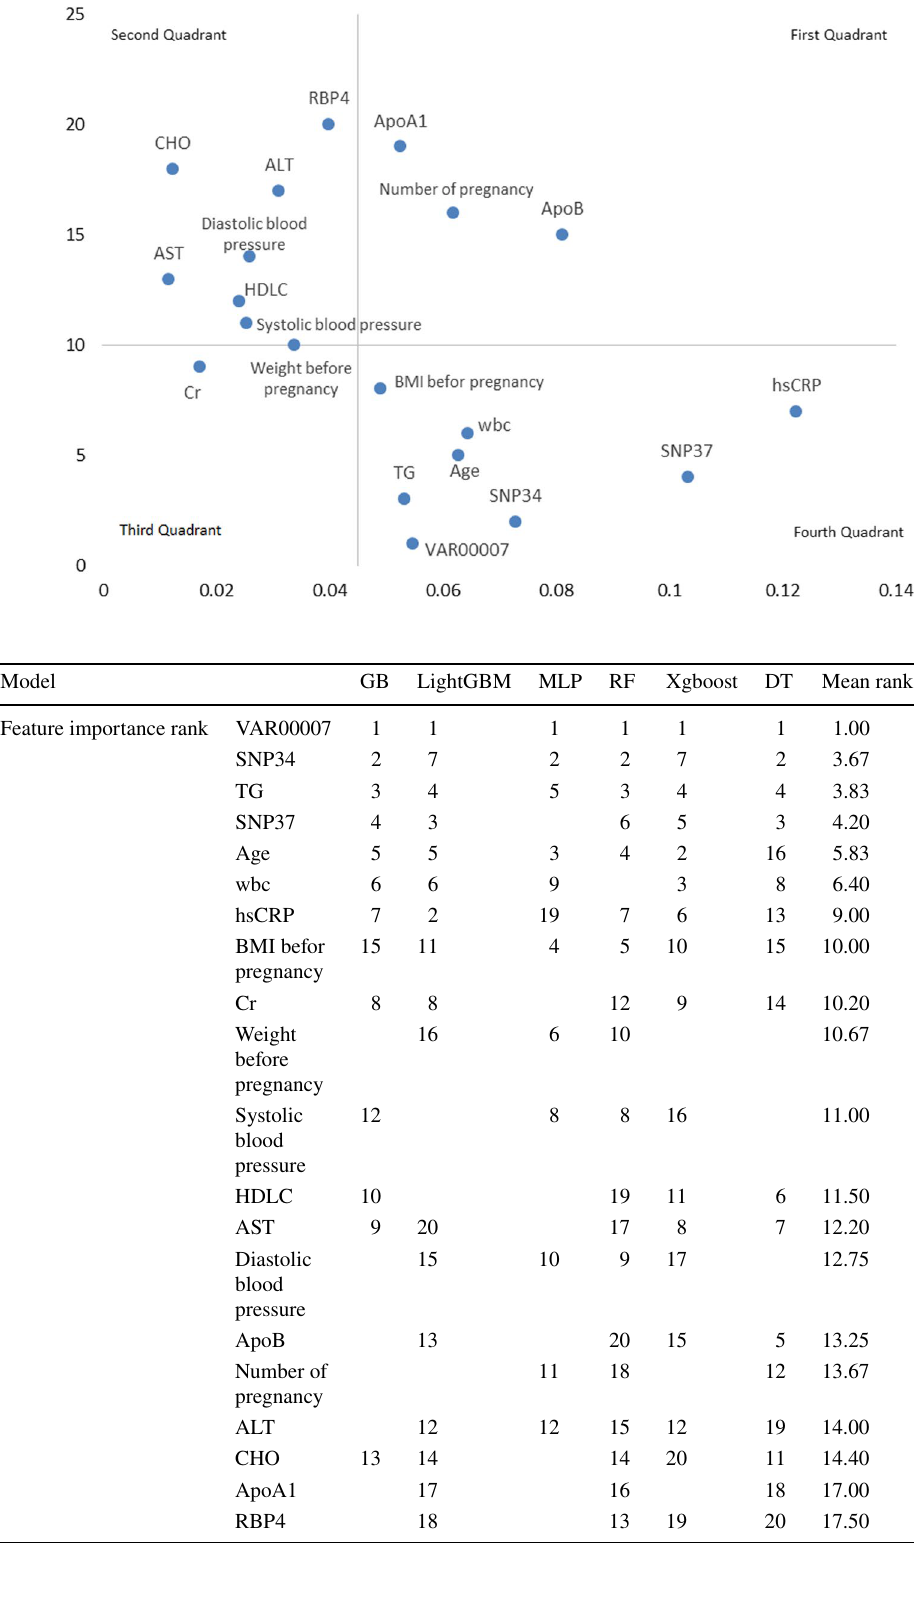
Fig. 4 Quadrant distribution of 20